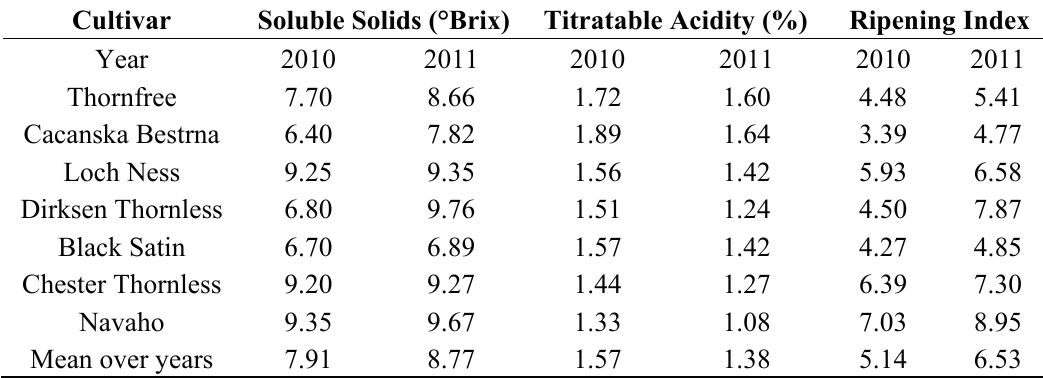
Table 2. Soluble solids, titratable acidity and ripening index of blackberry fruits grown in Serbia